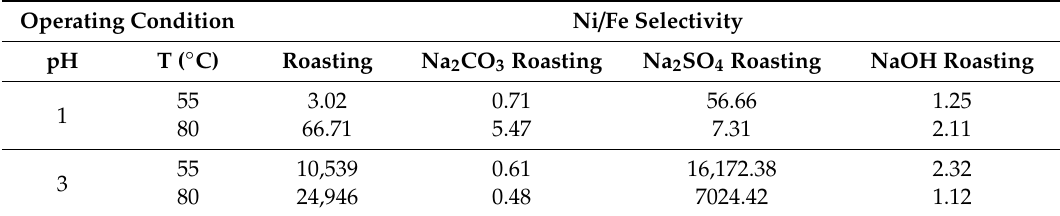
Table 2. The selectivity of nickel over iron in various pH and temperature.